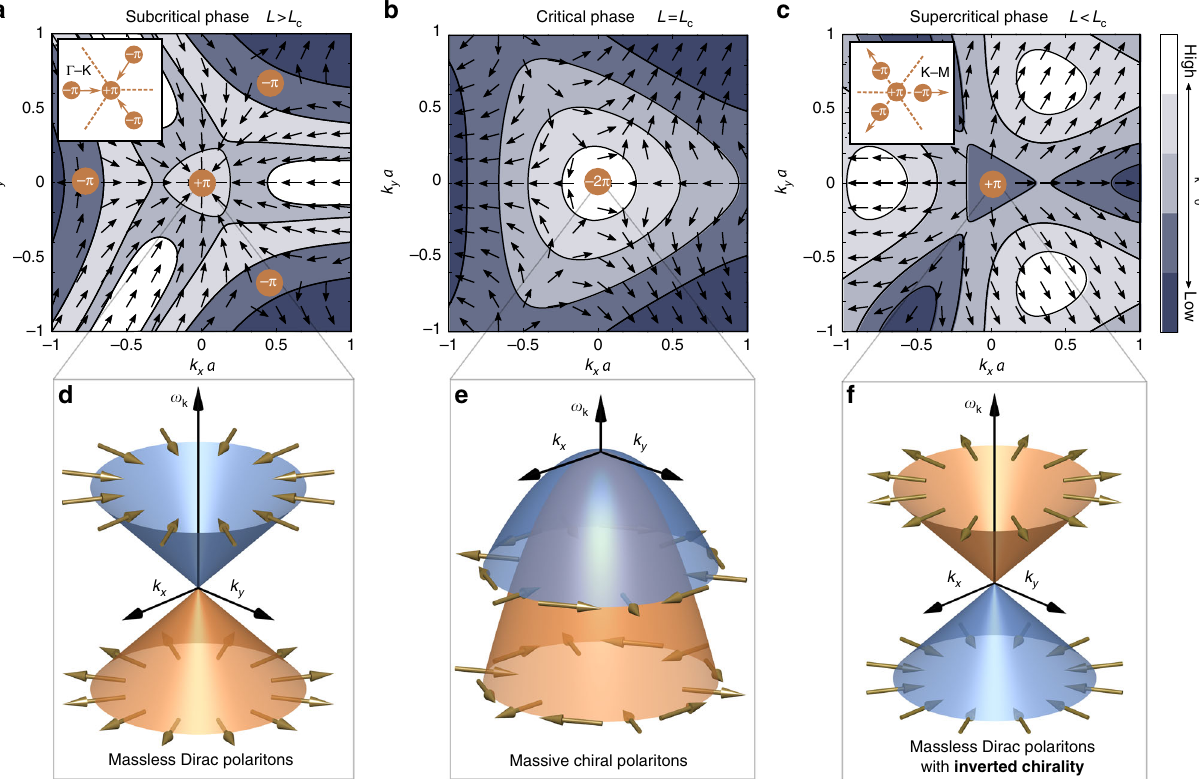
Fig. 5 Merging of type-I and type-II Dirac points with chirality inversion. a – c Pseudospin vector fi eld and isofrequency contours (see Methods for the speci fi c isofrequency values) for the upper polariton band near the K point for a subcritical ( L = 2.3 a ), b critical ( L = L c = 1.78 a ), and c supercritical ( L = 1.4 a ) cavity heights, respectively, as obtained from H . The Dirac points (corresponding to vortices) are depicted by orange circles along with their mat associated Berry fl ux. Before criticality, three type-II SDPs ( − π Berry fl ux) are driven towards the type-I CDP ( π Berry fl ux) along the Γ − K directions as the cavity height is reduced (see inset in a ). At the critical cavity height L c , they merge together forming a quadratic band-degeneracy with combined Berry fl ux of − 2 π (see b ). After criticality, the type-II SDPs re-emerge and are driven past the type-I CDP along the K − M directions (see inset in c ). After a small decrease in cavity height, these SDPs annihilate other SDPs that migrate along the opposite direction and have opposite Berry fl ux, leaving only the type-I CDP remaining in the spectrum with π Berry fl ux (see c ). d - f , Effective polariton spectrum near the K point to leading order in k . The colors of the bands correspond to the chirality of the Dirac polaritons as de fi ned in the main text, where the orange and blue bands indicate a chirality of + 1 and − 1, respectively. The spinor eigenstates, represented by pseudospin vectors (gold arrows), describe d massless Dirac polaritons with a linear dispersion and Berry phase of π , e massive chiral polaritons with a parabolic dispersion and Berry phase of − 2 π , and f massless Dirac polaritons with a linear dispersion ¼ 2 : 5 ω Ω = 0.01 ω and Berry phase of π , but with inverted chirality. All pseudospin and contour plots are obtained with ω ph 0 and K 0